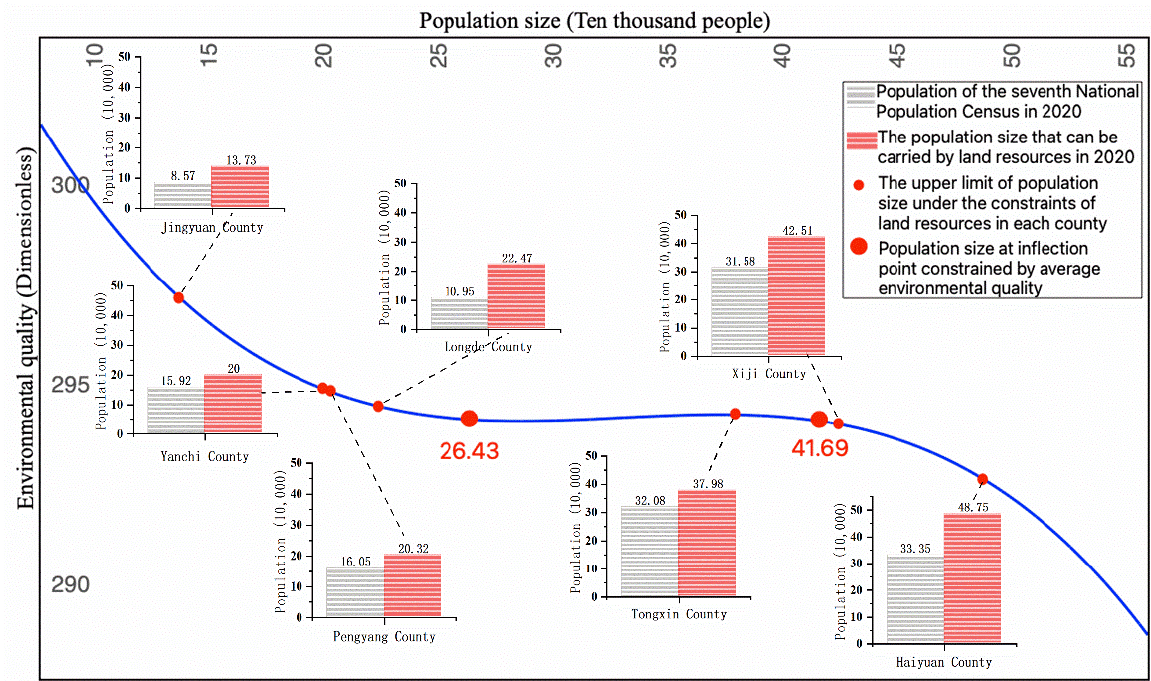
Figure 5. Interval analysis of sustainable population size at the county level in the limited develop- ment ecological zones of Ningxia.